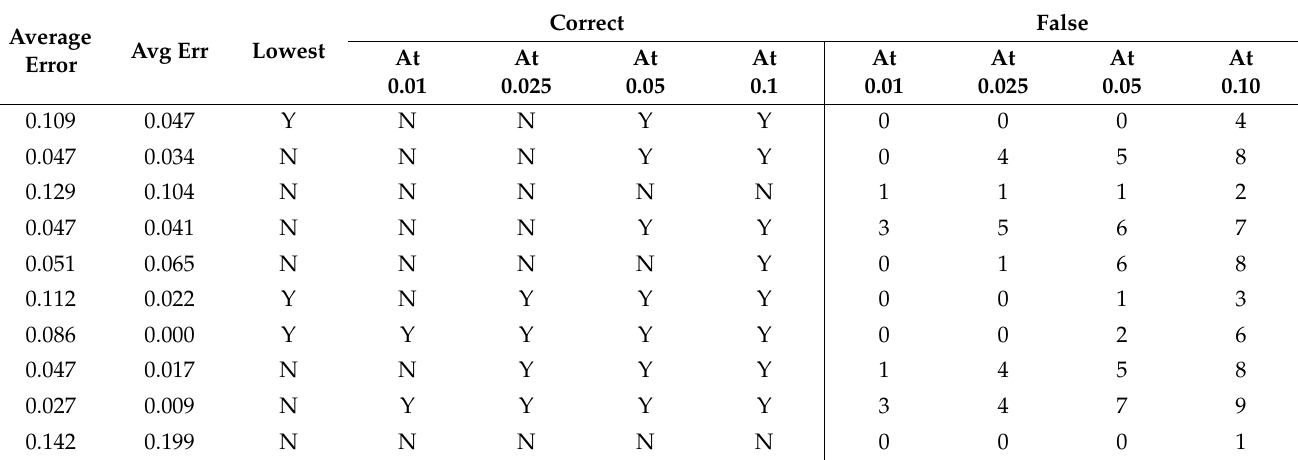
Table A231. Set 3, trials 41–50 summary data (average actual PR